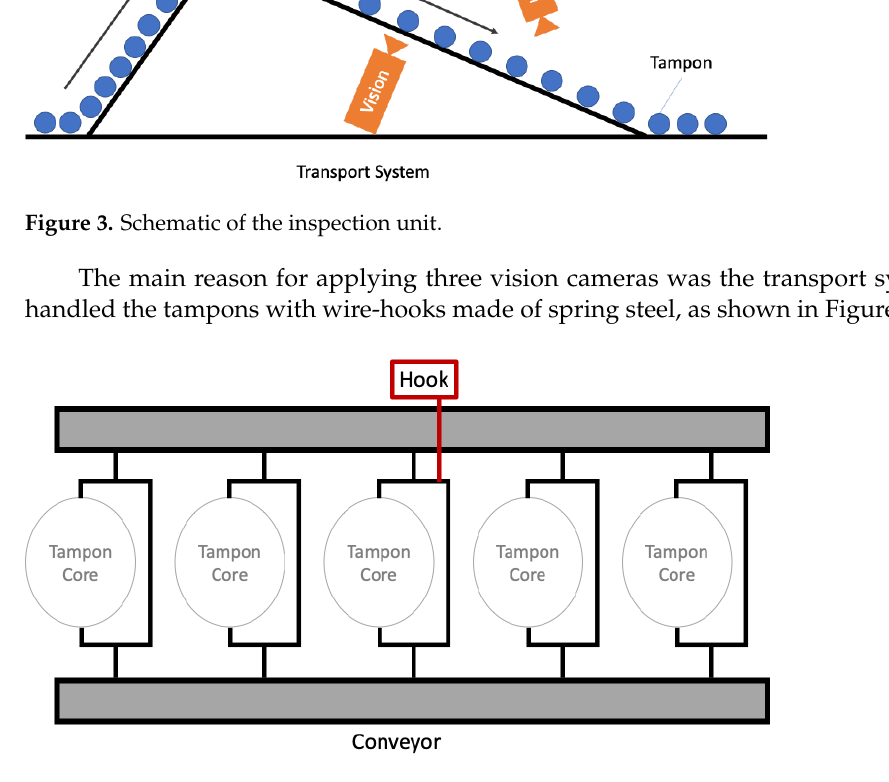
Figure 4. Hook-based transport system for